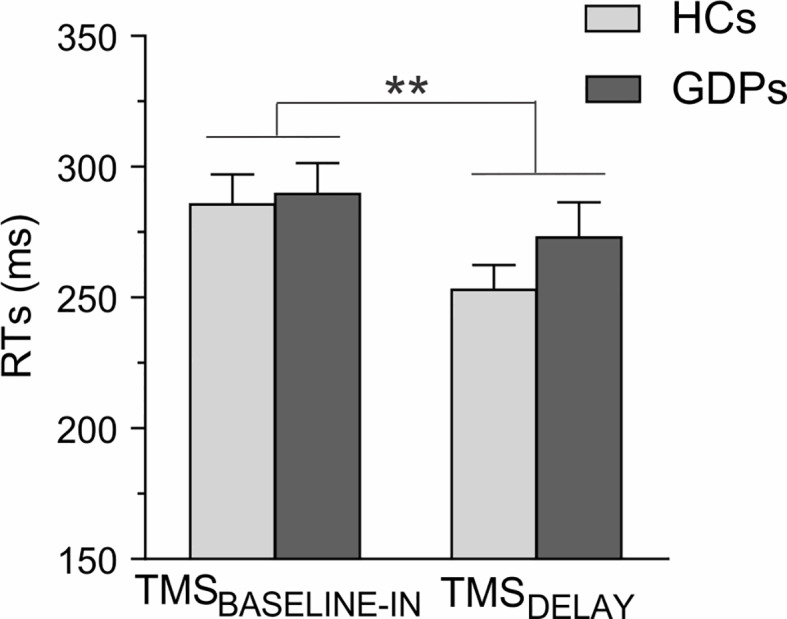
Reaction times (RTs) during the rolling ball task. The RTs are shown for trials in which the TMS pulses were applied either at baseline (TMSBASELINE-IN) or during action preparation (TMSDELAY) for HCs (light gray) and GDPs (dark gray). Data from responses performed with both hands are pooled together, as the main effect of RESPONDING-SIDE was not significant (F1,24 = 0.02; p = 0.89). Please note the shortening of RTs at TMSDELAY. **p < 0.01: significantly different.